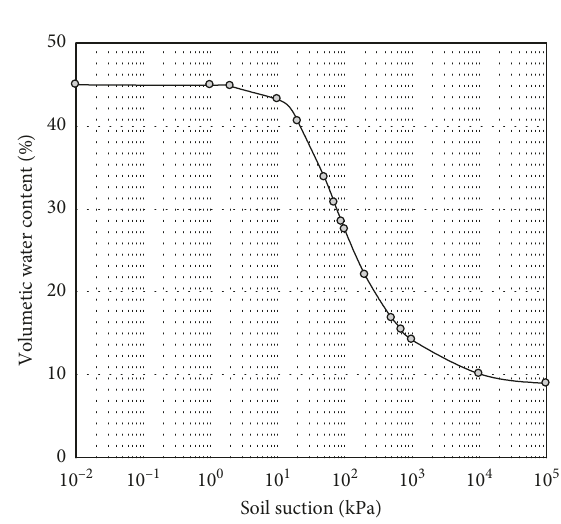
Figure 7: Soil-water characteristic curve.